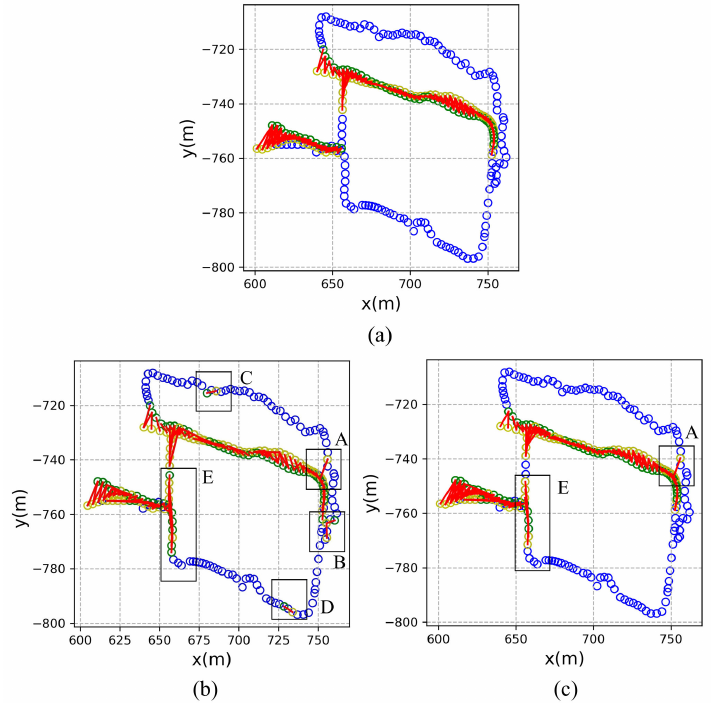
Figure 9. Results visualization of recognized places on the New College dataset. ( a ) The ground-truth trajectory. ( b ) Using triplet loss. ( c ) Using multi-constraint